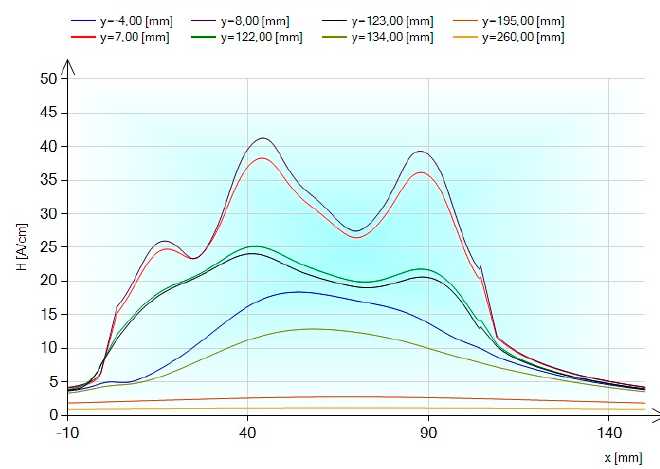
Figure 12. The distribution of magnetic field intensity of an unshielded busbar system for x = var (variables) and different values of y = const in the case of current symmetry.